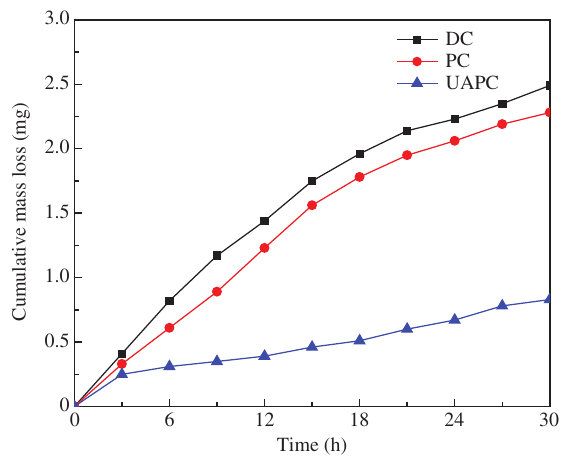
Figure 6 Weight loss curves of Ni-AlN thin films after corrosion: (A) DC, (B) PC, and (C) UAPC methods.